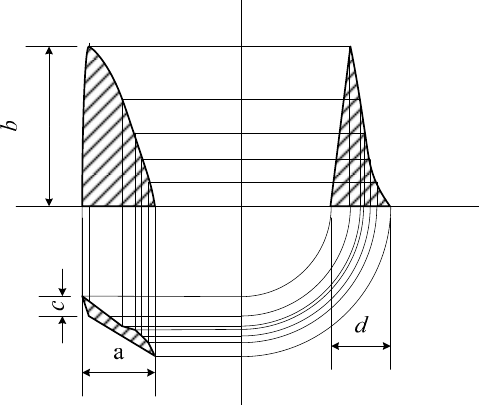
Figure 4. Projection of the forming tool and the plate contact area.